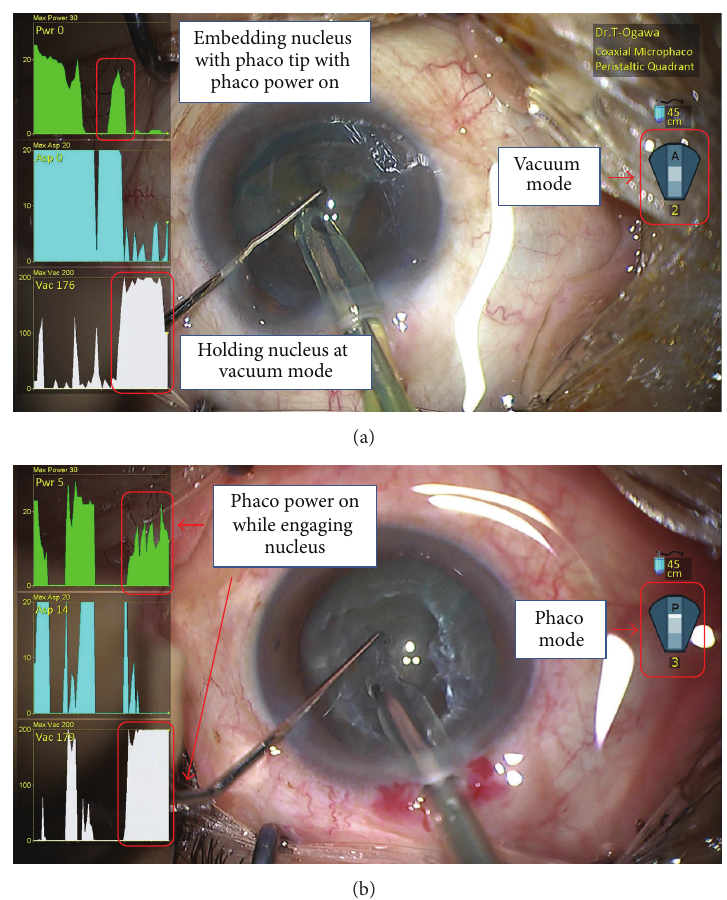
Figure 4: Nucleus fragmentation technique. (a) Correct nucleus fragmentation technique. (b) Case 1, inappropriate nucleus fragmentation